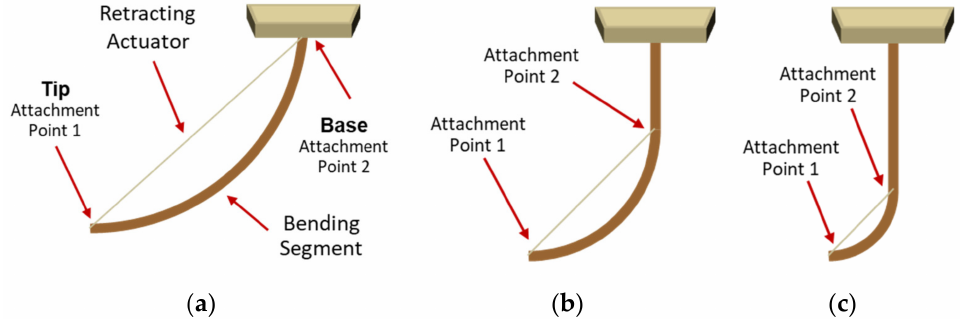
Figure 2. Different actuator attachment points create different bending segment lengths: ( a ) Initial location of the SAP. ( b ) SAP moved to two-thirds of the body. ( c ) SAP at one-third of the body.